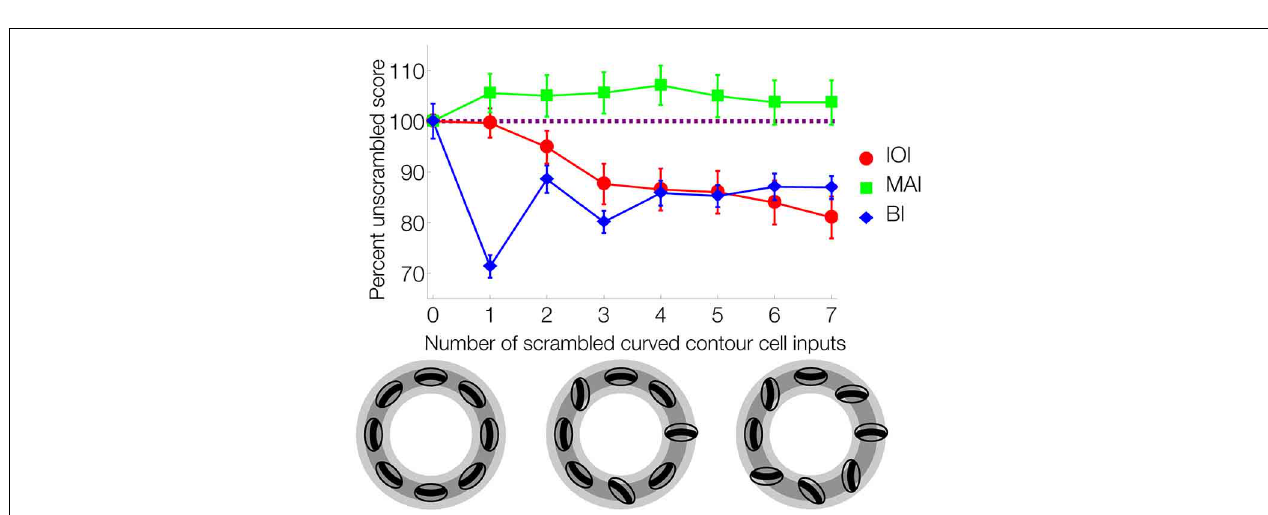
RF. The teardrop cell activity only changes modestly when squares of different sizes are presented (size invariance), whereas the convex cell only responds when the square reaches a certain size. The activity of each cell is normalized separately to convey differences in the response properties.